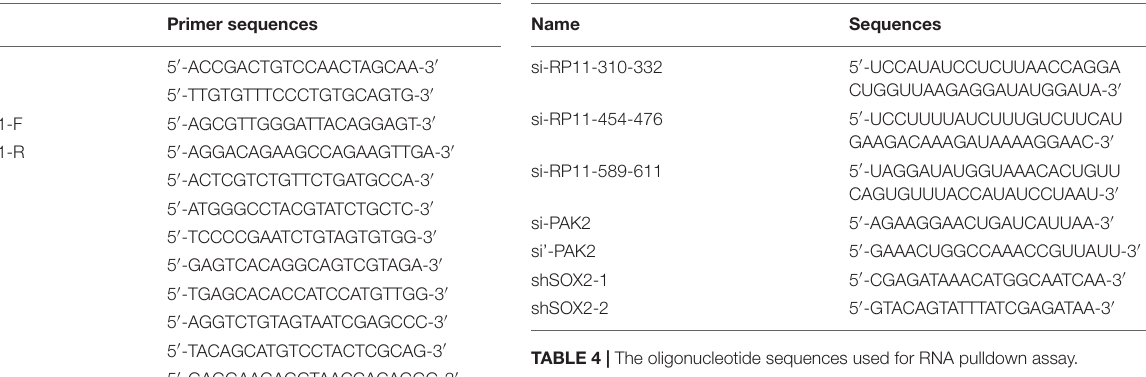
TABLE 2 | The sequences of the primers used in qRT-PCR. TABLE 3 | The sequences of siRNAs and shRNAs used in cell transfection.